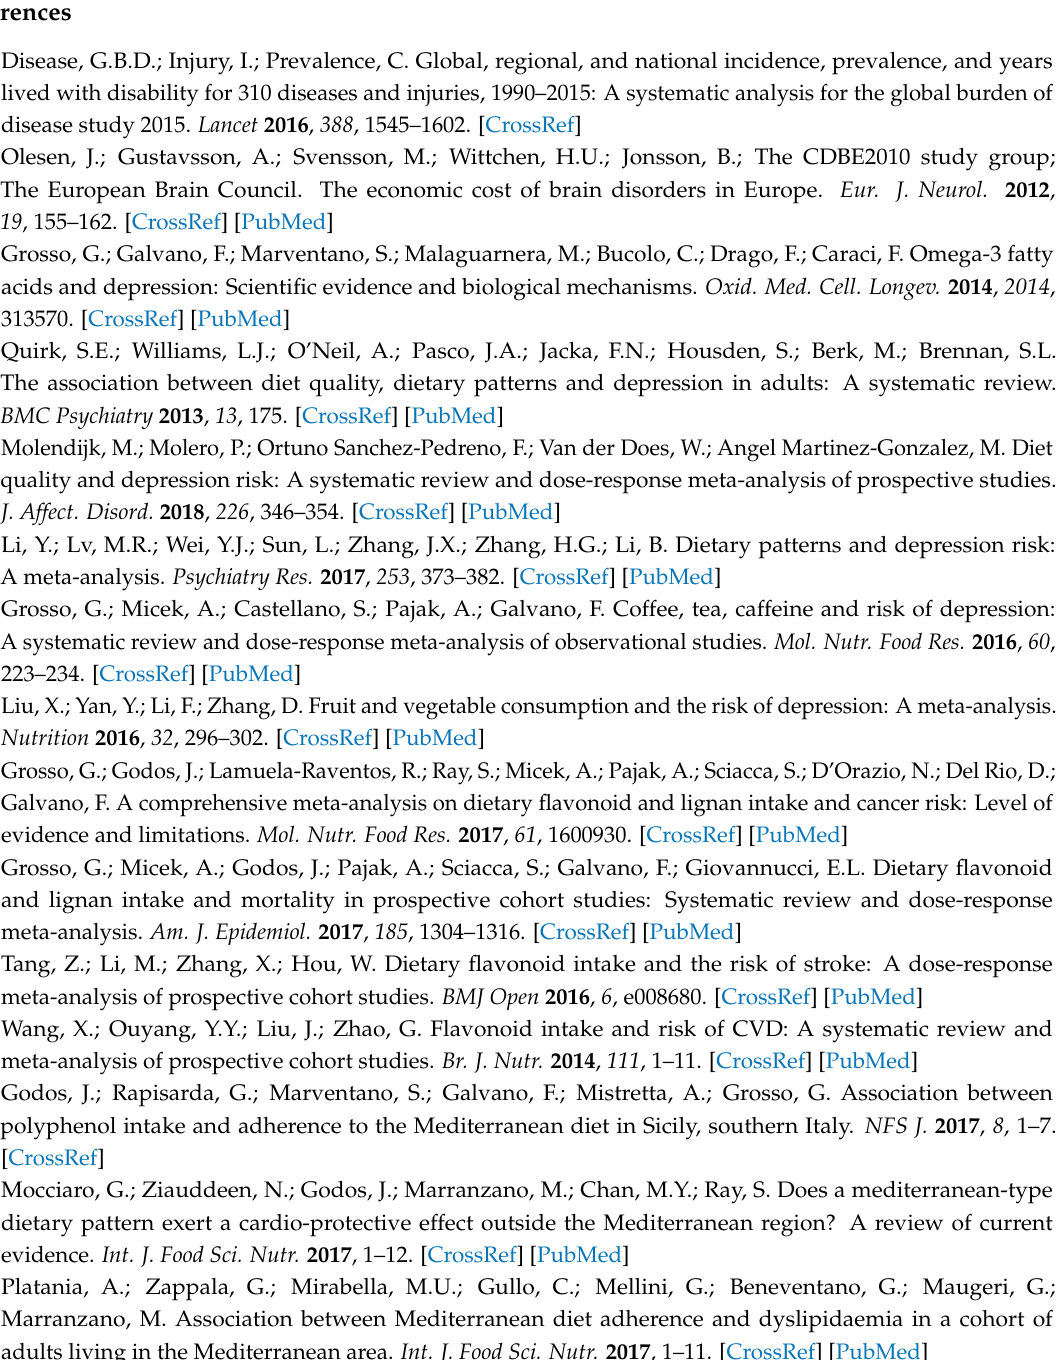
Table S1: Selected dietary factors by quartiles of total polyphenol intake